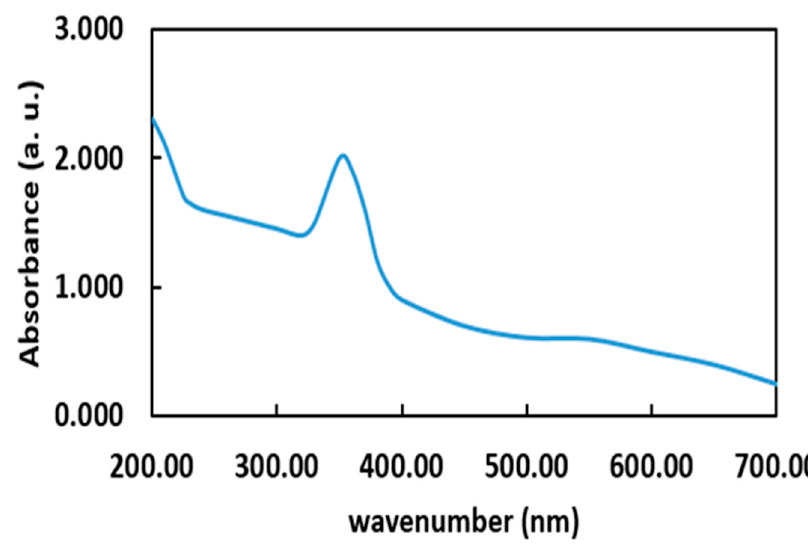
Figure 1. UV–visible spectra of synthesized ZnO NPs.